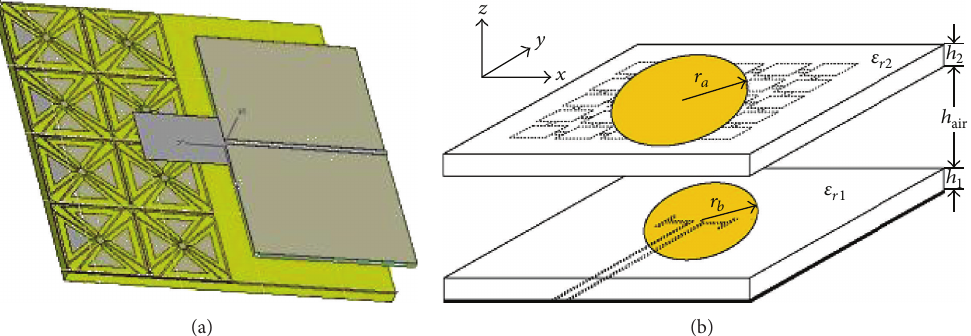
Figure 14: EBG with microstrip antenna: (a) monopole over bow-tie EBG and (b) stacked CPW-fed circular microstrip antenna over rectangular